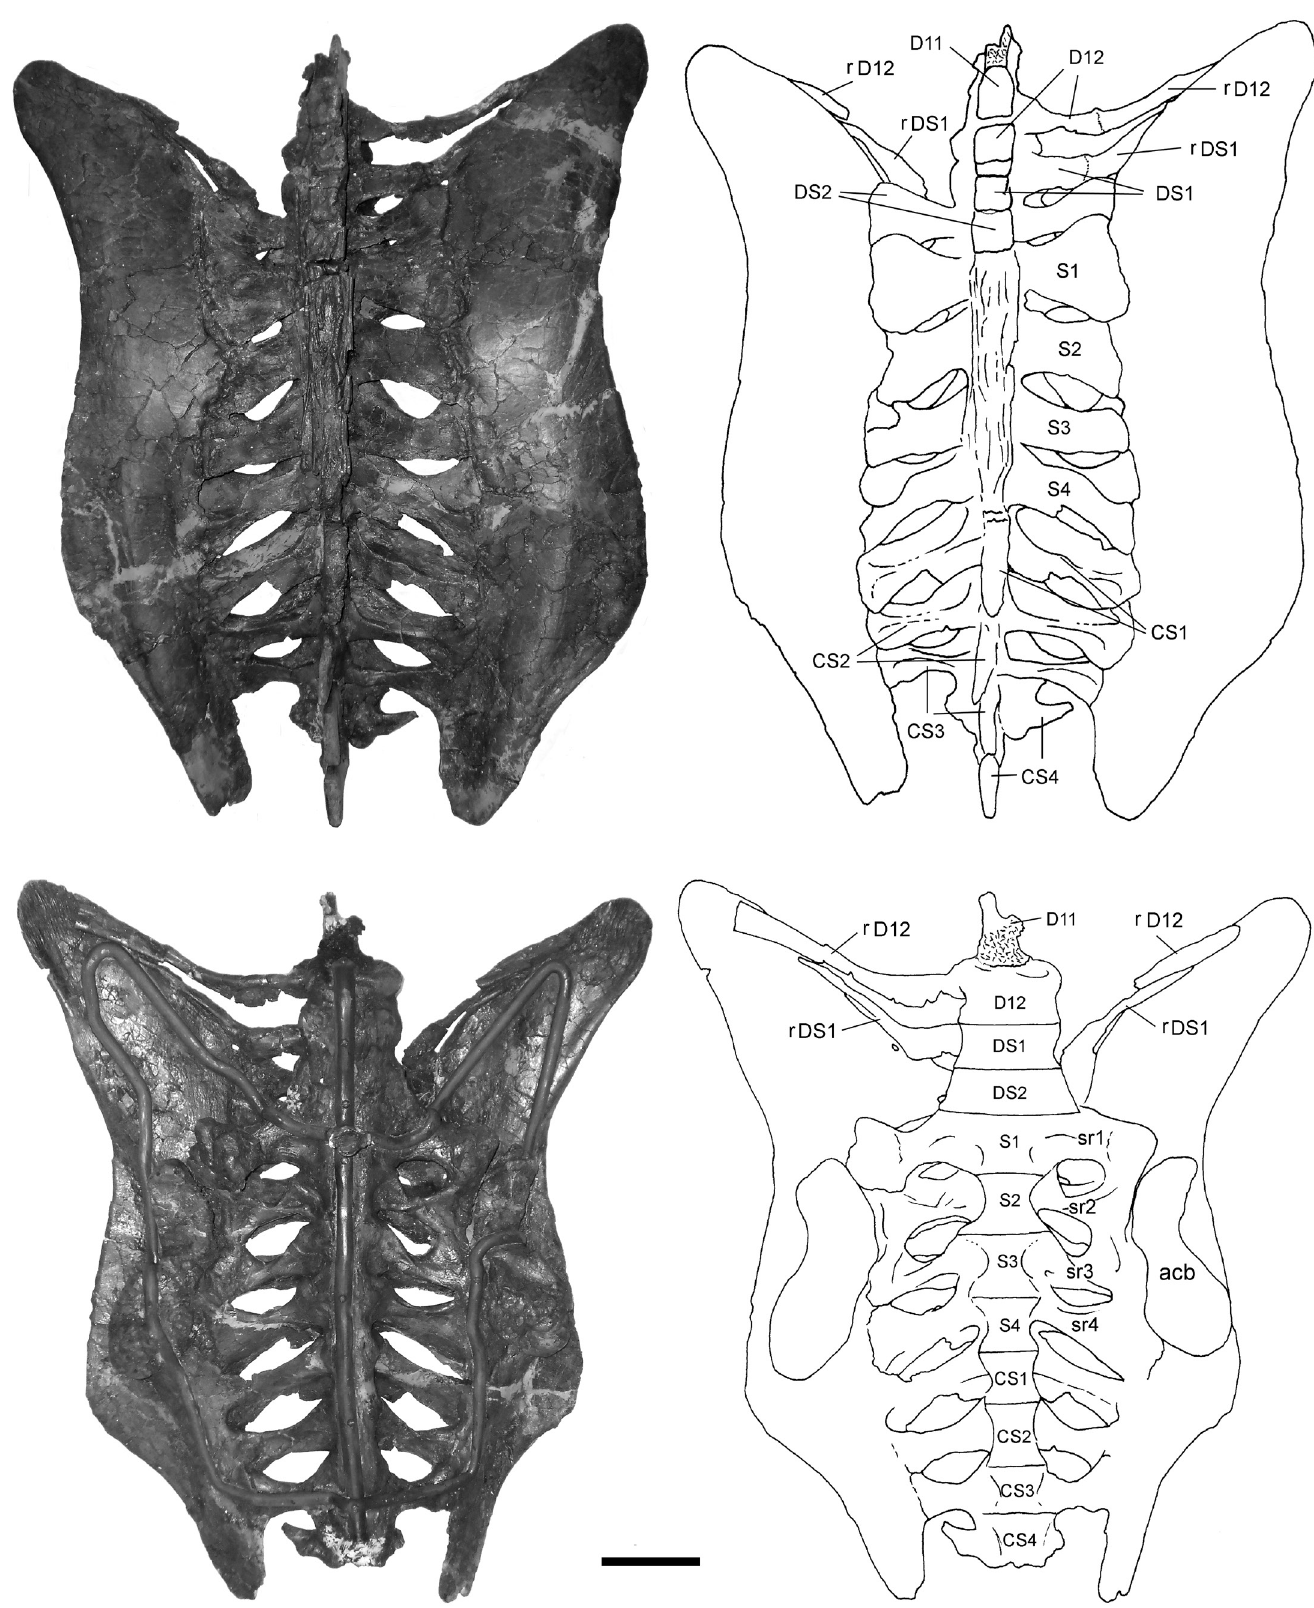
Figure 12. Synsacrum and pelvis of Chasmosaurus belli (ROM 843) in dorsal (upper) and ventral (lower) views. The neural spine (but not the arch or the centrum) of the 11th dorsal vertabra is preserved in articulation with the last (12th) dorsal ver- tebra. The latter has fused to the front of the synsacrum. Two dorsosacrals, each with almost completely co-ossified dorsov - entrally flattened ribs lacking capitular processes, are